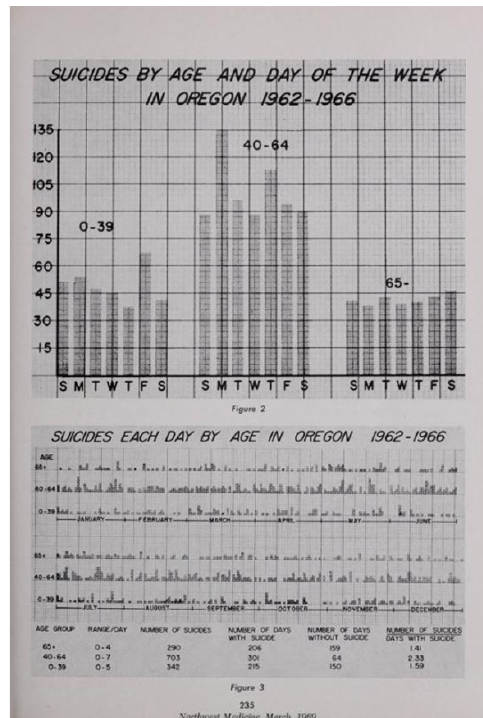
Figure from the article, “A Market Analysis for Suicide Prevention; Relationship of Age to Suicide on Holidays, Day of the Week and Month,” from the March 1969 issue of Northwest